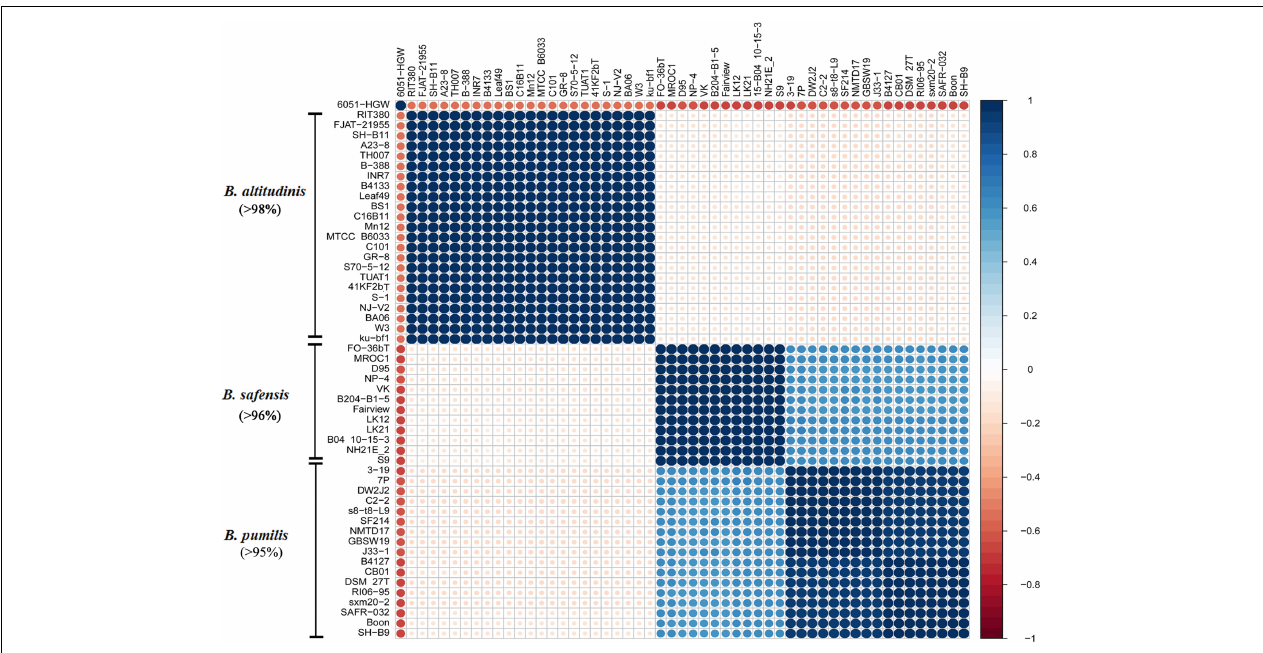
FIGURE 2 | Correlation plot based on strains’ ANI values. ANI values between each strain were calculated using JSpecies software and employed for Pearson correlation matrix construction conducted using R. The plot shows the correlation constructed and ordered by hierarchical clustering using the R package “corrplot.” The minimum percentages of ANI values between the strains of a given cluster are indicated in